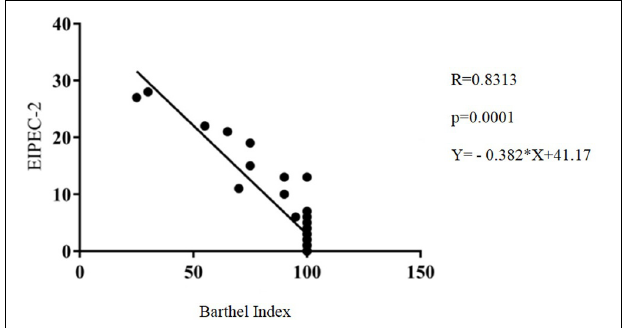
FIGURE 1 | Correlation of the Evandro Chagas Research Institute Neurological Disability Scale (EIPEC-2) with the Barthel Index, Belém,